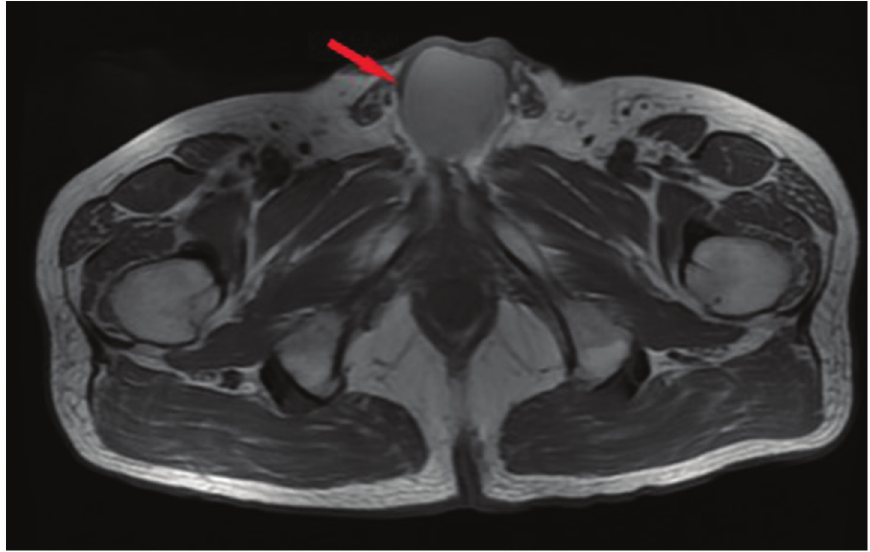
Figure 3. T1-weighted images showing a round-like abscess in the cavernous body of the penis root.